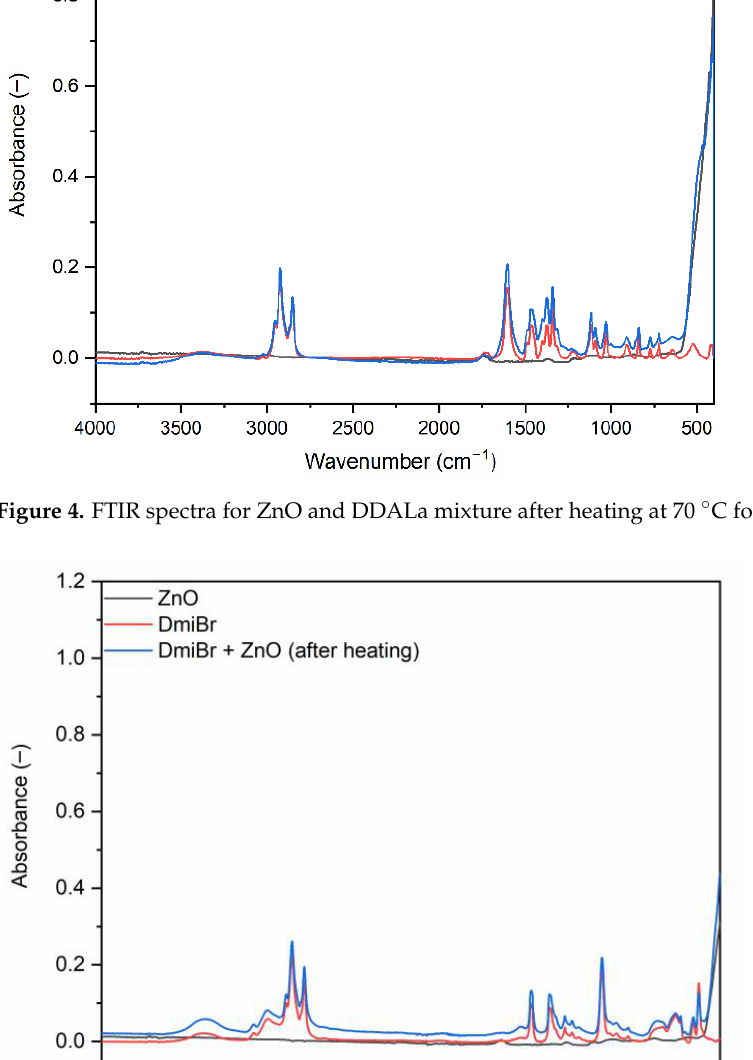
Figure 6. Fourier Transform Infrared Spectroscopy (FTIR) spectra for DDALa and lactic acid— identification of bands characteristic for lactate anion of DDALa. Regarding the FTIR spectra presented in Figure 4, the C=O stretching bands at 1717 1435, 1399, 1371 and 1339 cm −1 , which are characteristic of the carboxyl group of lactic acid and lactate anions, were identified. The following bands characteristic for the O–H stretch- ing vibrations of the lactic acid component were identified at 3377 and 2988 cm −1 , while the bands in the region 1217–920 cm −1 correspond to stretching modes of C–C and C–O functional groups. The bands occurring at the wavenumbers below 910 cm −1 (909, 840, 772, 642 and 527 cm −1 ) generally refer to C–H vibrations (bending, deformation). The bands at 1116 and 1031 cm −1 correspond to –CH 3 group and C–C bonds of lactate anions and in the case of DDALa also to C−C bonds of didecyl chains and –CH 3 group of didecyldime- thylammonium cations. Additional bands at 2923 and 2854 cm −1 in the FTIR spectrum of